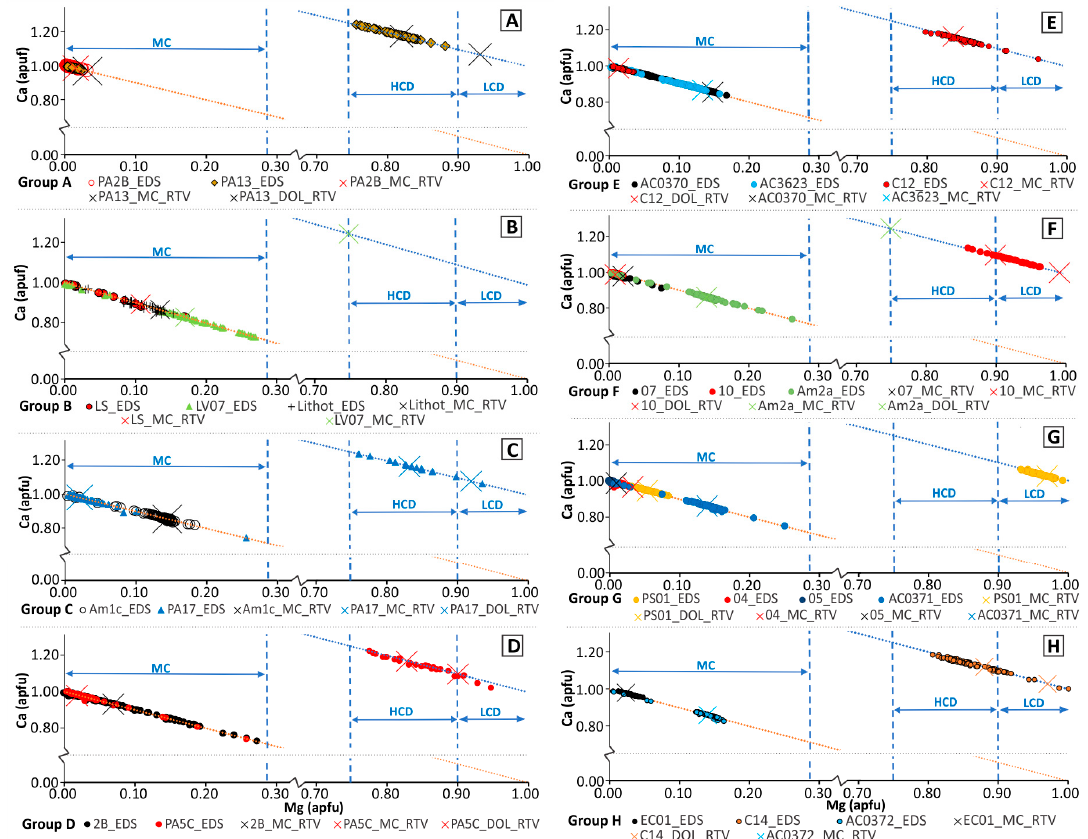
Figure 6. Results of energy-dispersive X-ray fluorescence spectrometer (EDS) analyses represented by circles, triangles, and diamonds, as compared to the Rietveld method (RTV) results represented by X, for magnesian calcite (MC), low calcium dolomite I (LCD), and high calcium dolomite II (HCD). ( A – H ) Different groups of samples separated for clearer visualization. Data in Table S5.